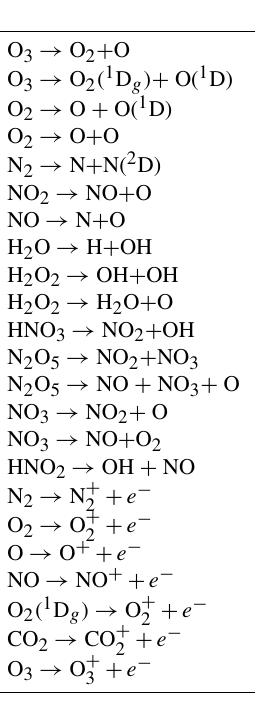
Table 2. Photodissociation and photoionization reactions of the SIC